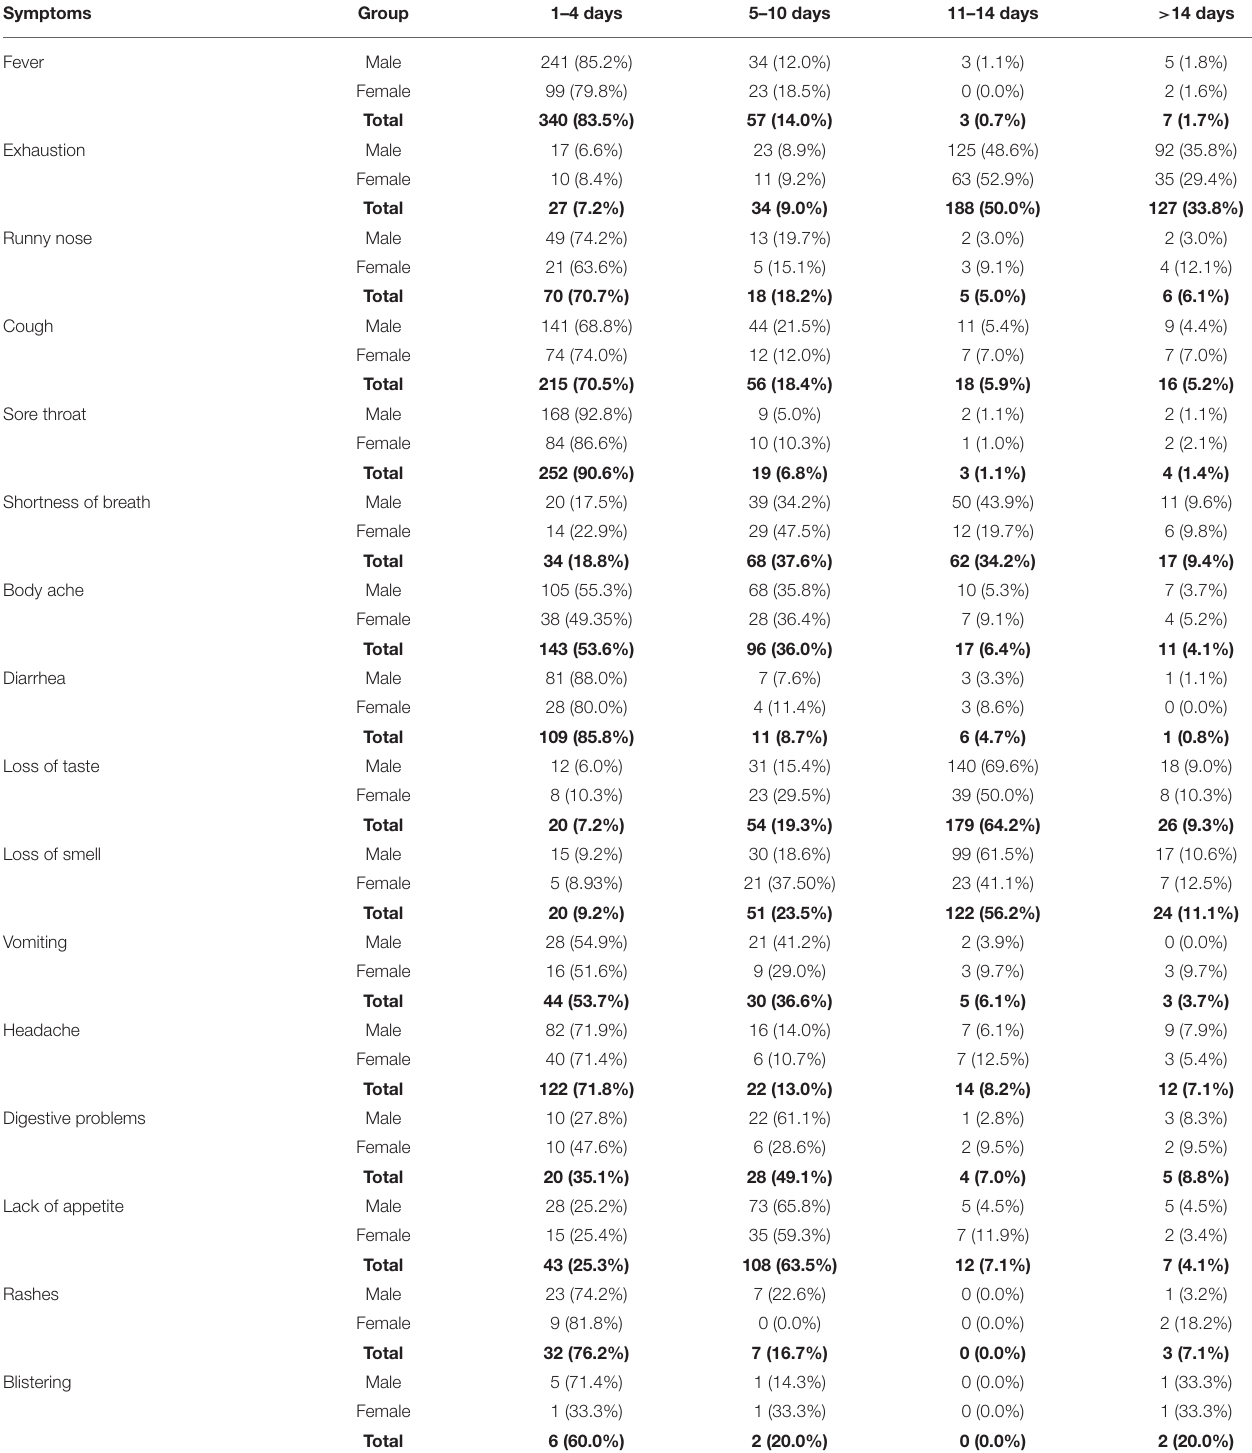
TABLE 6 | Duration of the COVID-19-associated symptoms of the patients, Bangladesh, 2020.